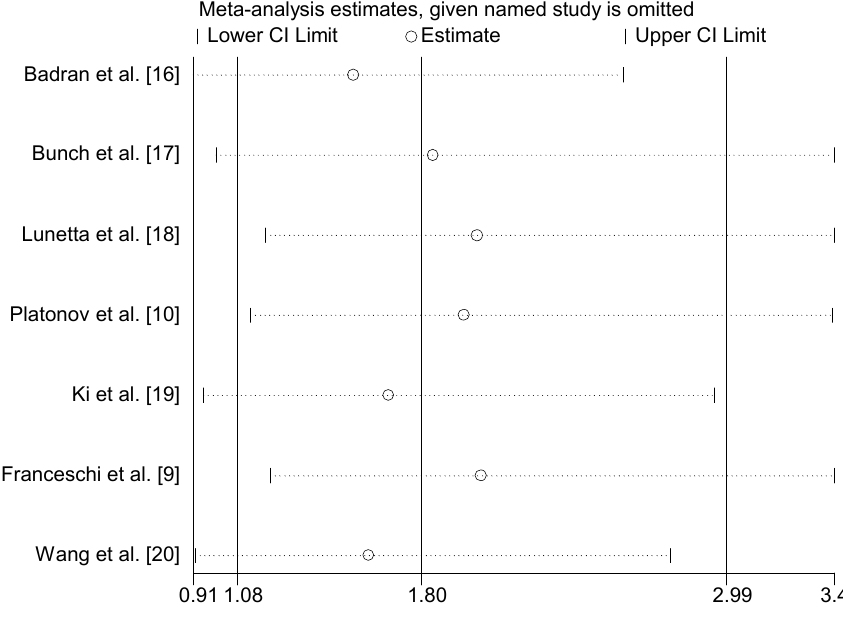
Figure 5. Sensitivity analysis of the meta-analysis.